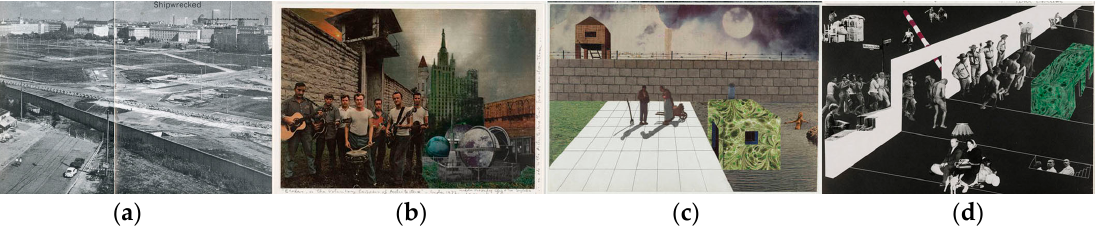
Figure 6. Rem Koolhaas and the Wall. ( a ) Photo from S , M , L , XL , 1977; ( b ) Photo-montage